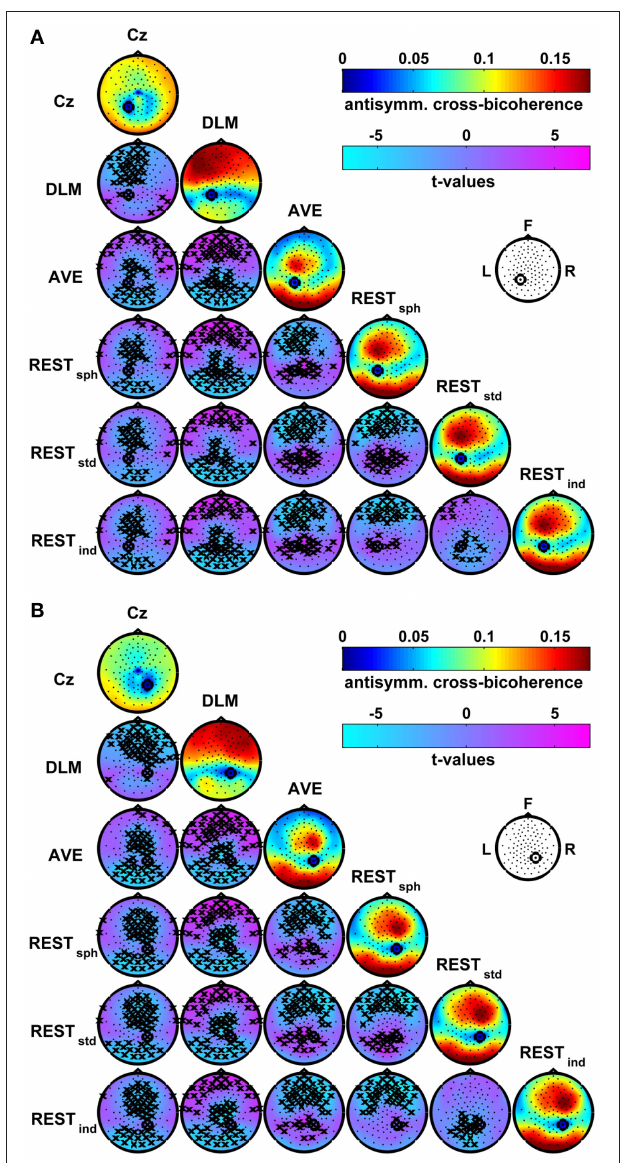
FIGURE 7 | Effects of the EEG reference choice on the estimation of alpha-beta connectivity using the antisymmetric cross-bicoherence. Panel (A) : maps of connectivity with seed channel P1. Panel (B) : maps of connectivity with seed channel P2. The seed channels have been marked by a black circle. Main diagonals: maps of the average antisymmetric cross-bicoherence across subjects obtained for the different EEG reference schemes. Off-diagonals: maps of t -values for pairwise contrasts between antisymmetric cross-bicoherence maps from different EEG reference schemes using a paired-sample t -test; the black crosses mark the channels showing significant differences at the p < 0.05 level (two-tailed) based on a permutation test (10,000